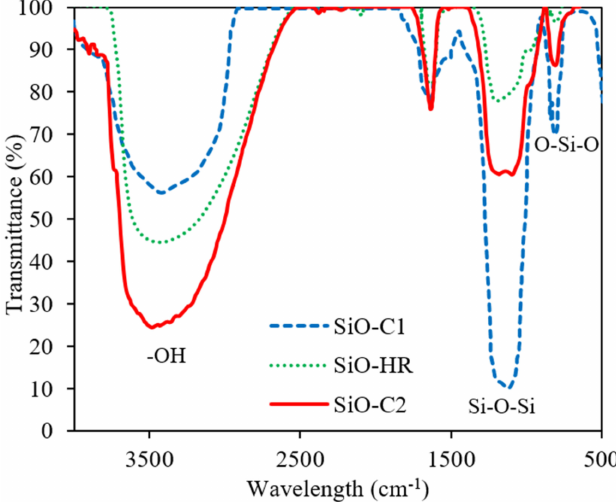
Figure 7. FTIR spectra of silica-based nanoparticles from commercial silica-based nanoparticles SiO 2 -C 1 and SiO 2 -C 2 , and silica-based nanoparticles in-house synthesized from rice husks (SiO 2 -RH) used for bio-nanofluid system tuning.